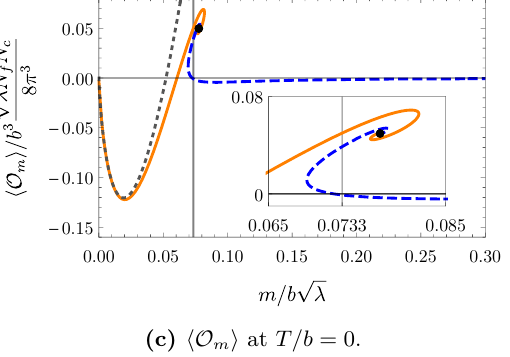
Figure 1. (a) Examples of our numerical solutions for R ( r ) / ( L 2 b ) as functions of r/ ( L 2 b ) , at T/b = 0 . The dashed blue, solid orange, and dot-dashed black lines are solutions obeying the r → 0 boundary conditions in eqs. (3.6a) (Minkowski), (3.6b) (black-hole-like), and (3.6c) (critical), respectively. (b) Our numerical result for the free energy density f/ ( b 4 λN f N c ) , as a function of √ 16 π 4 m/ ( b λ ) , at T/b = 0 , with the same colour coding as (a). The dotted gray line is the small mass approximation in eq. (3.14). The black dot indicates the critical solution, and the inset is a close-up near the critical solution, showing the “swallow tail” shape characteristic of a first-order √ λ ) ≈ 0 . 0733 is indicated by the vertical grey line. transition. The first order transition at m/ ( b √ λ ) limit of the free energy, f ≈ − b 4 λN f N c / (512 π 4 ) . The horizontal grey line shows the large m/ ( b √ √ λN f N c (c) The expectation value hO m i / ( b 3 λ ) , at T/b = 0 , with the same ) as a function of m/ ( b 8 π 3 colour coding as (a) and (b). The dotted gray line is the small mass approximation in eq. (3.13). The inset is a close-up of the spiral behaviour near the phase